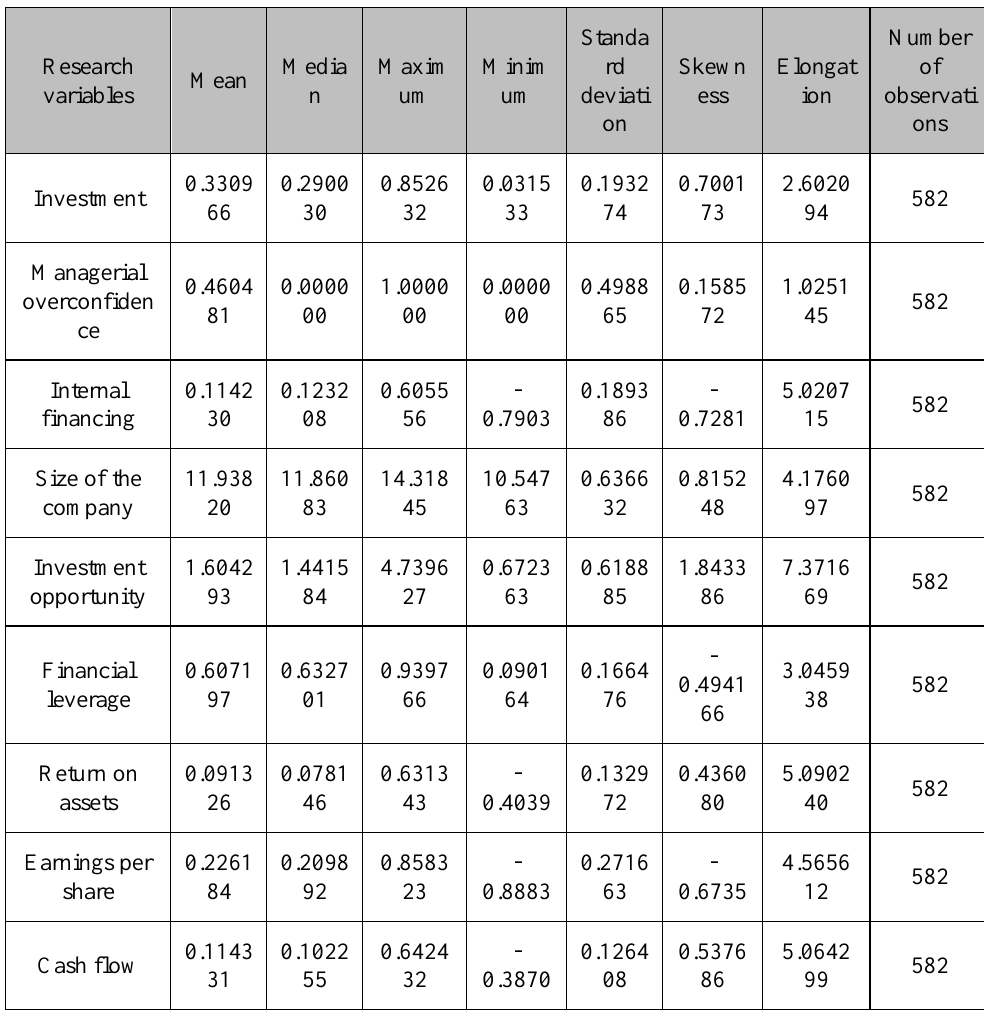
Table 2. Descriptive